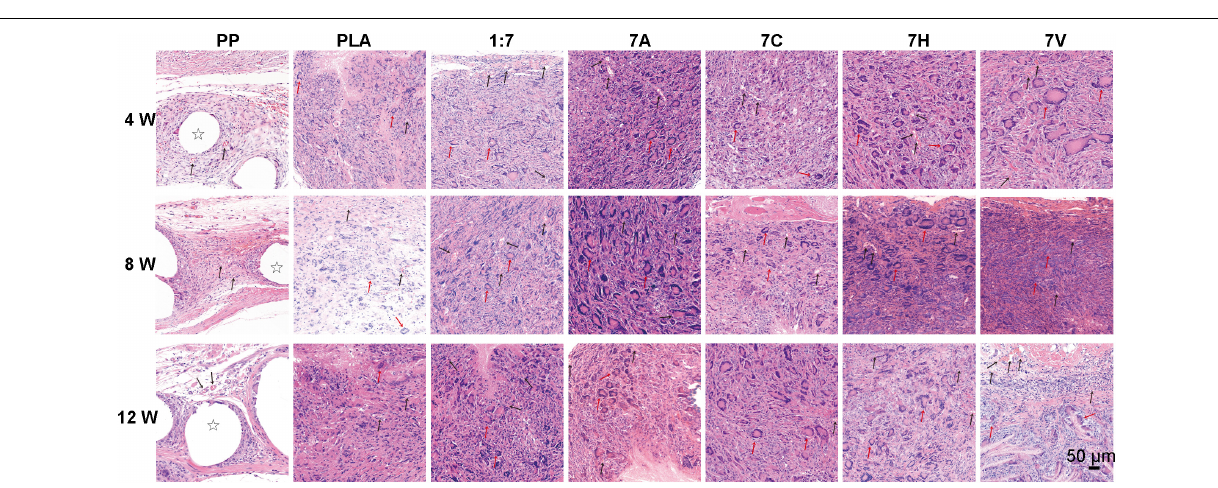
FIGURE 5 | H&E staining used to evaluate histology of scaffolds after 4, 8, and 12 weeks of implantation (Scale bar = 50 µ m). Stars indicate PP mesh fibers. Black arrows indicate vessel lumen in regenerative tissue. Red arrows indicate foreign body giant cells in regenerative